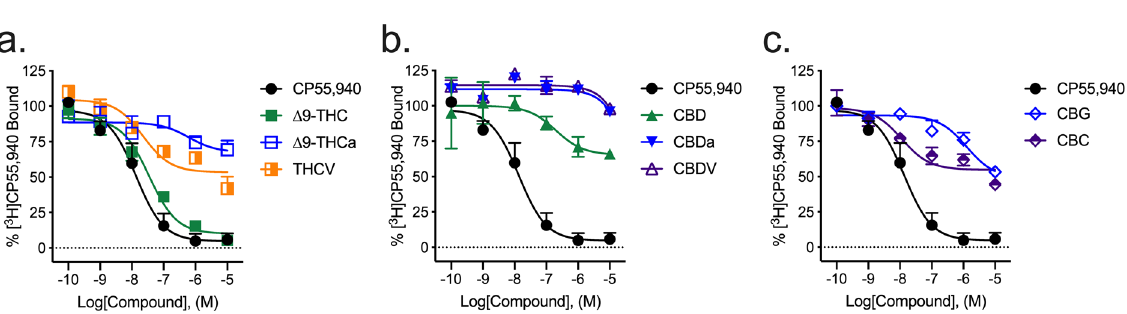
Figure 2. [ 3 H]CP55,940 displacement from hCB1R CHO cell membranes. Compound activity was quantified for [ 3 H]CP55,940 binding in CHO cells stably expressing hCB1R and treated with 0.1 nM–10 µM ( a ) THC-like compounds; ( b ) CBD-like compounds; or ( c ) CBG, or CBC. Data were fit to a variable slope (4 parameter) non- linear regression in GraphPad (v. 8). n ≥ 6 independent experiments performed in duplicate. Data are expressed as mean ± SEM. K i and E min are reported in Table